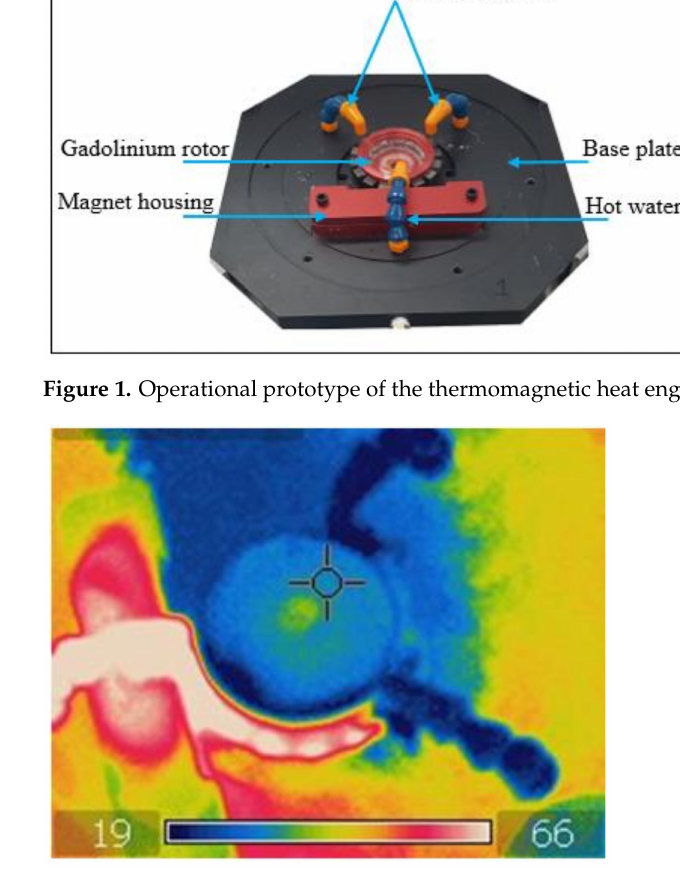
Figure 2. Temperature zones of thermomagnetic heat